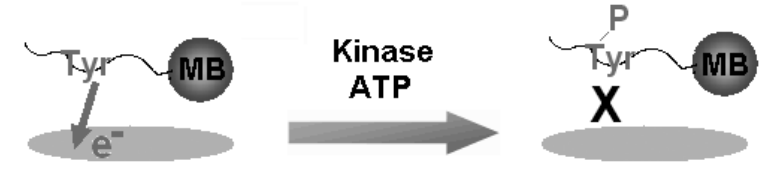
Figure 2. Schematic illustration for the label-free detection of tyrosine-kinase catalysed peptide phosphorylation. The peptides that are conjugated with a magnetic bead (MB) contain a single phosphorylation site such as tyrosine (Tyr). Since Tyr has intrinsic electro-activity, the current response from its voltammetric oxidation is monitored. Under optimized conditions, Tyr residue is phosphorylated in the presence of a tyrosine kinase and ATP. During phosphorylation, the phosphate group at the γ -position of ATP is transferred to the hydroxyl group of Tyr. The intrinsic electro- activity of Tyr is lost upon phosphorylation and the current response decays with the increasing concentration of the tyrosine